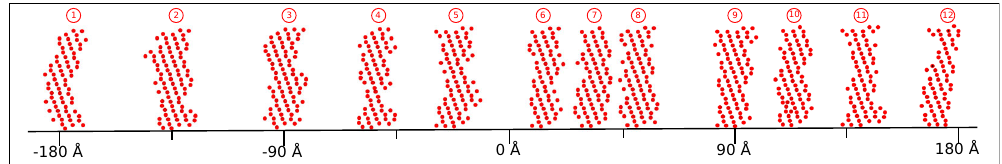
Fig. 3 Dislocations at their minimum energy locations on 360 Å portion of the long NbTaV sample. The distribution of the distances between the dislocations can also be observed. The dislocations are labeled and can be matched with their energies in Fig.